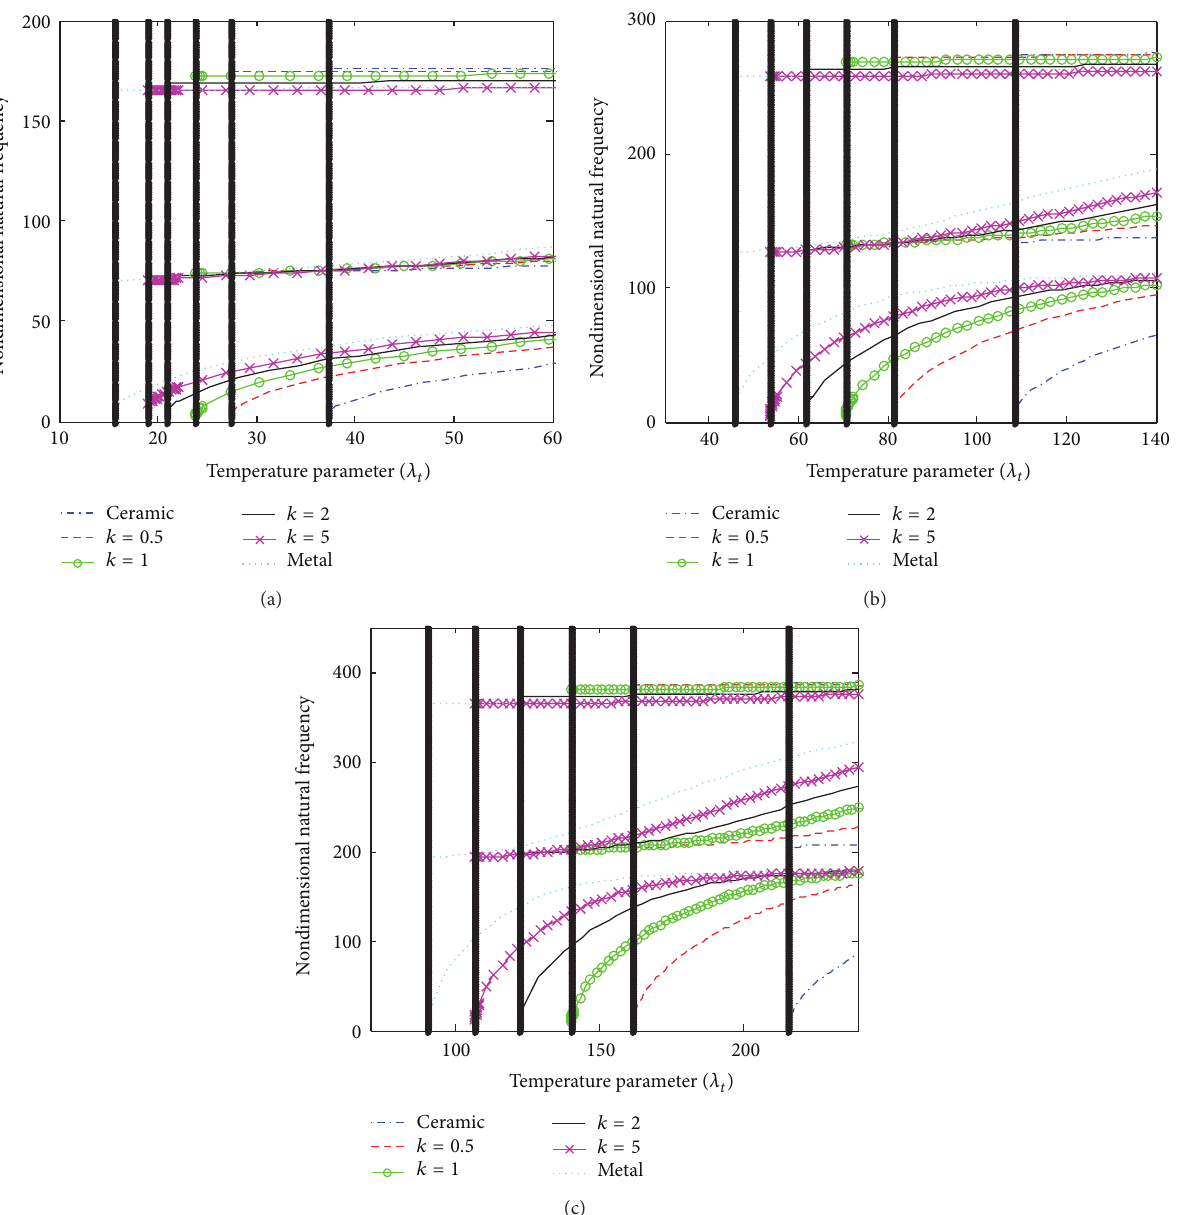
Figure 9: Variation of the nondimensional fundamental natural frequency of vibration around the (a) first, (b) second, (c) third buckling mode with the temperature parameter for a clamped-simply supported FG beam with different values of 𝑘 ( 𝑙/ℎ = 1 , 𝐿/ℎ = 40 ).